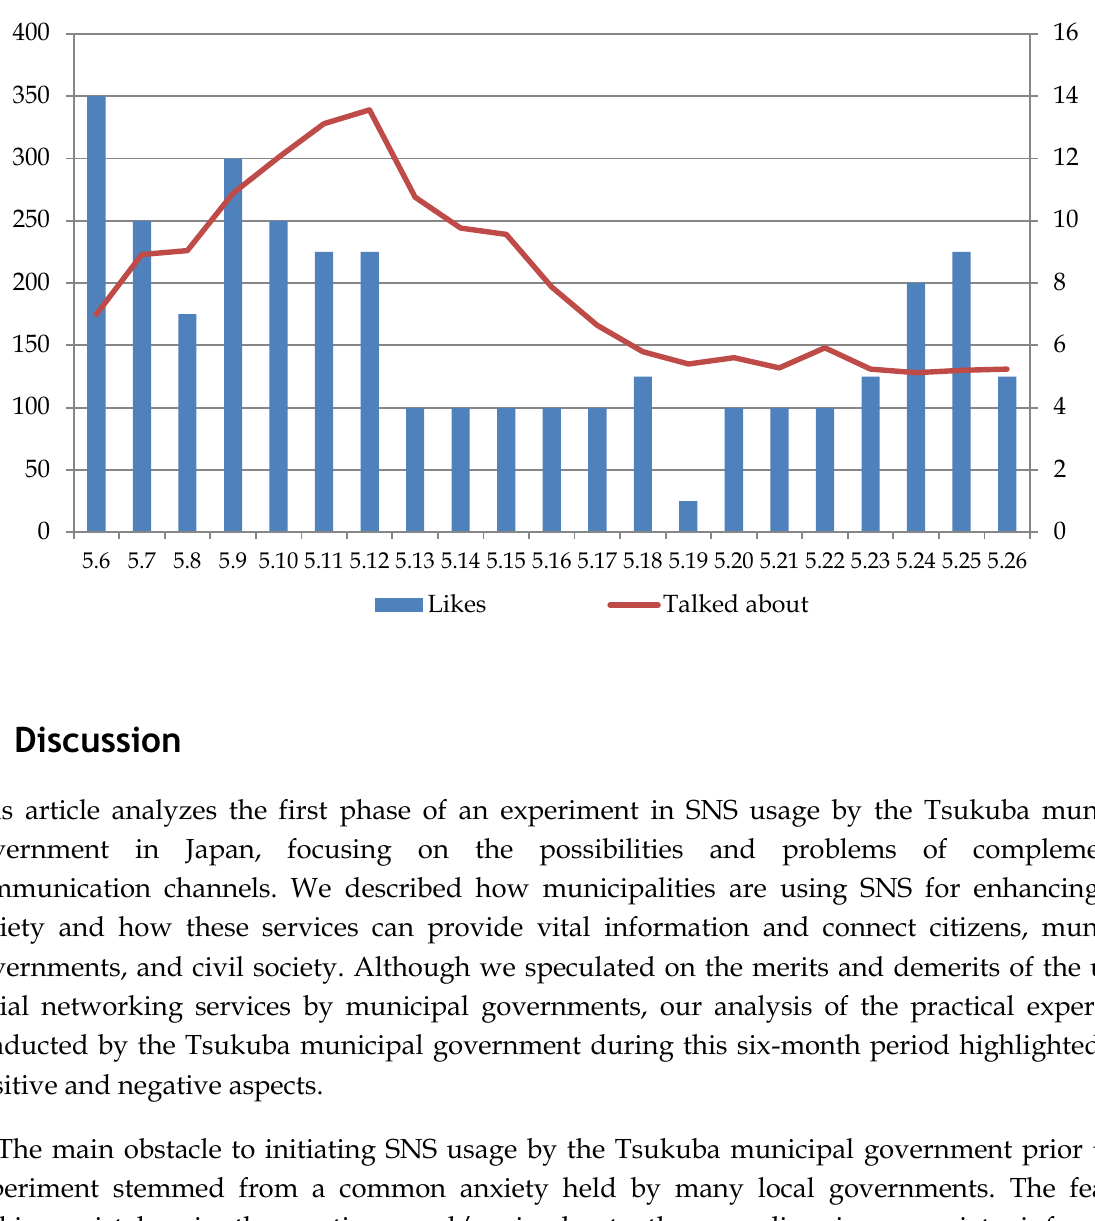
Figure 4: Likes and Talked about Concerning the May 6, 2012 Tornado Disaster, Tsukuba Civic Activities Cyber-Square (May 6 to May 26,